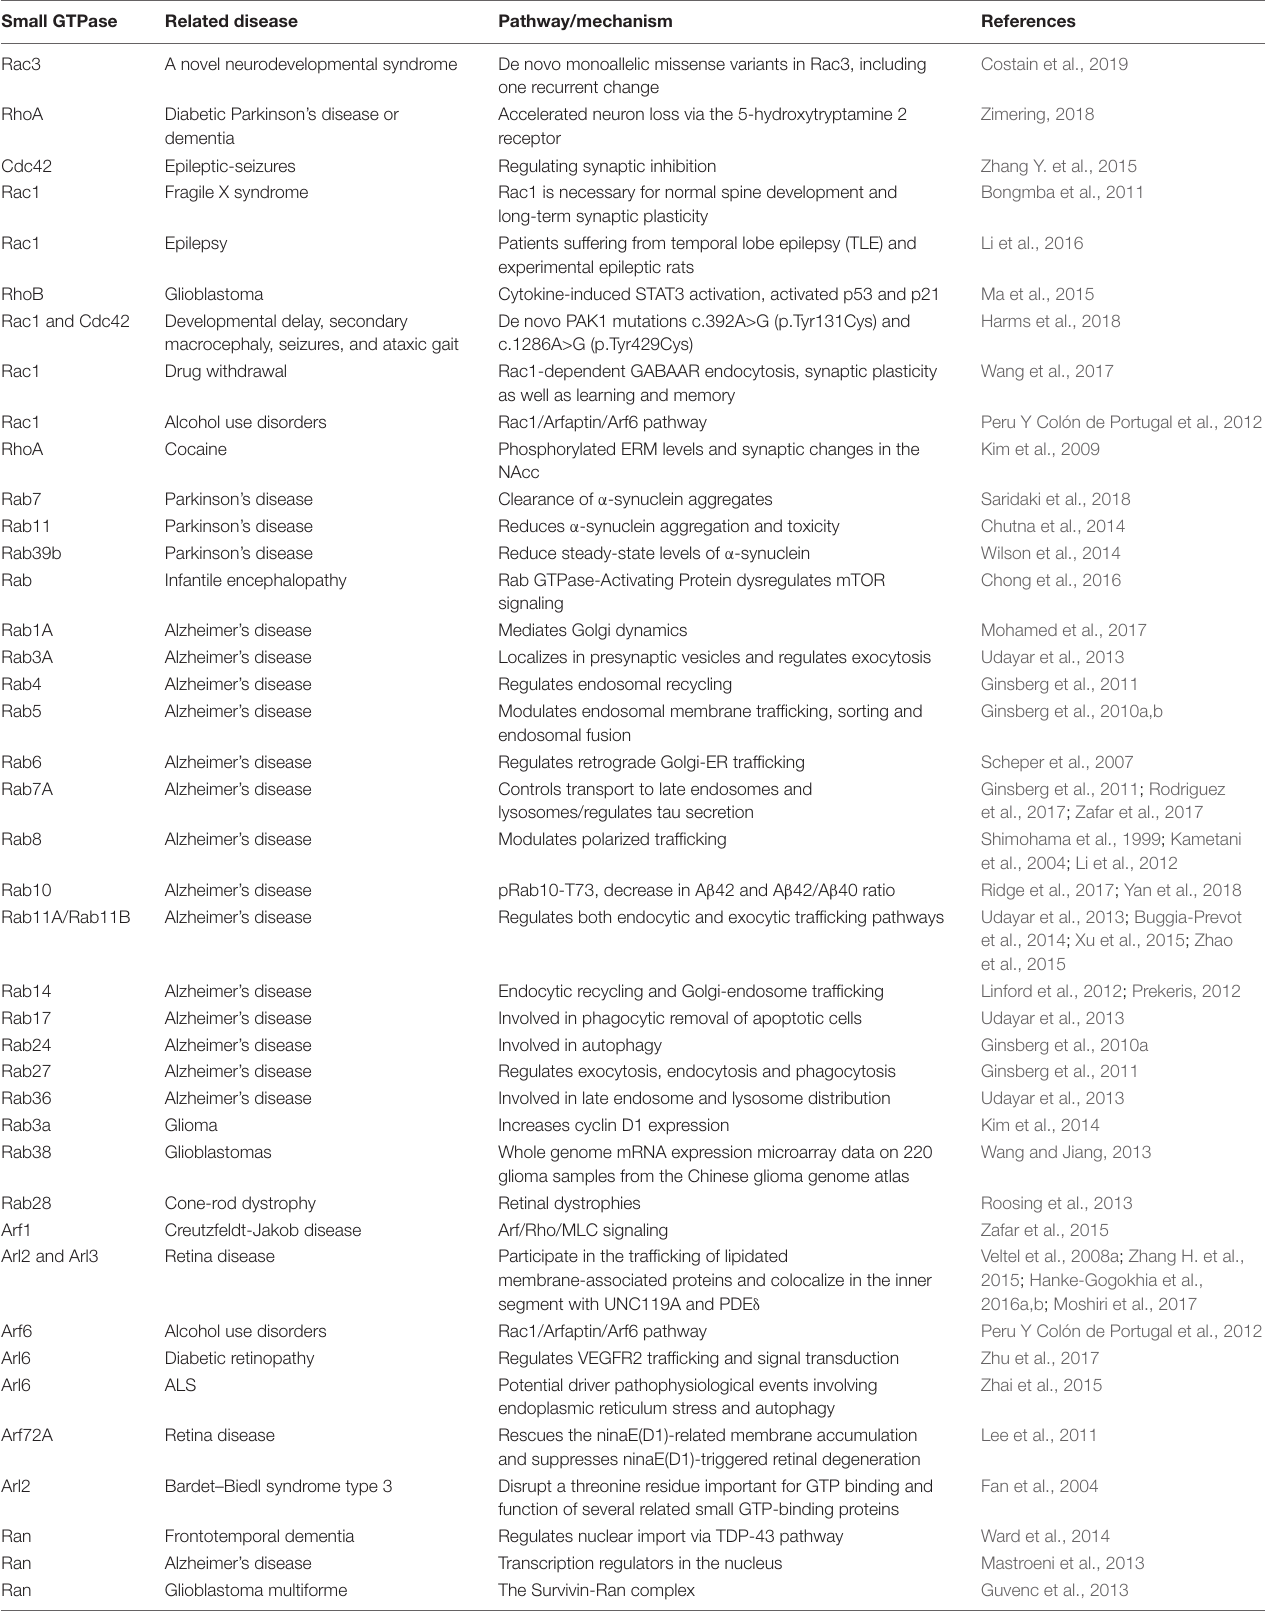
TABLE 3 | Small GTPases and Related Diseases (Rho, Arf, Rab, and Ran families). Small GTPase Related